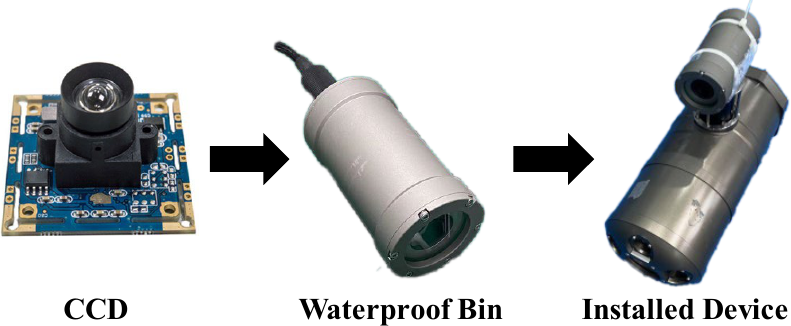
Figure 2. Underwater image acquisition device combined with optical communication probe.